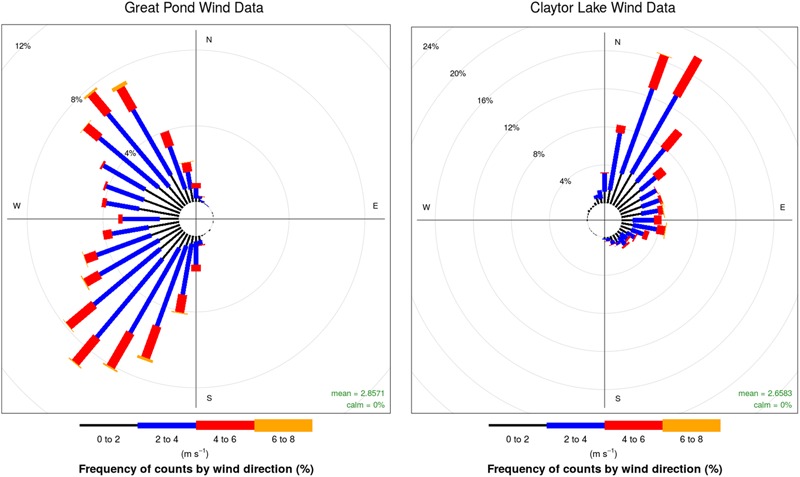
Wind plots for the Great Pond, Falmouth, MA, United States (Left) and Claytor Lake, Dublin, VA, United States (Right). Colors represent the speed of wind with length of bars representing the percentage of time at the given wind speed.